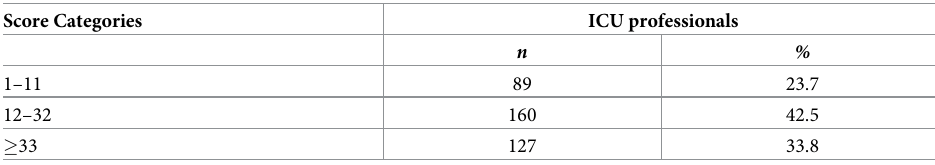
Table 2. Frequencies of IES-R score categories.